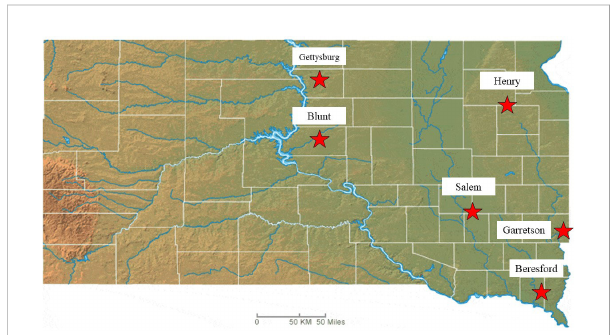
FIGURE 1 A map of the state of South Dakota indicating the selected study sites during the project between the fall of 2017 and the summer of 2020. source: